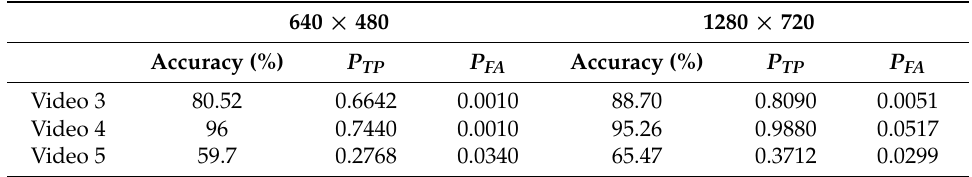
Table 9. HMM detection results at VGA and 720p resolutions.